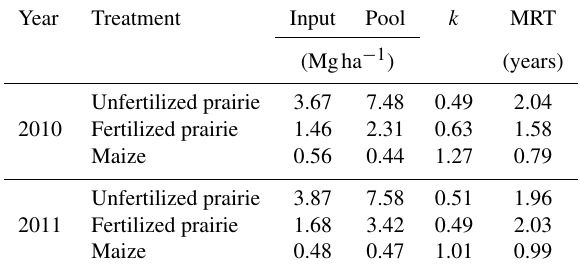
Table 3. Root turnover at